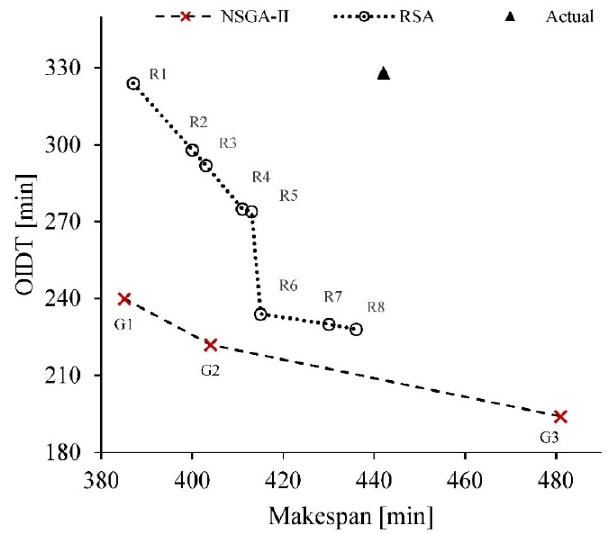
Figure 12. The solutions for BMP-I obtained by NSGA-II and RSA.